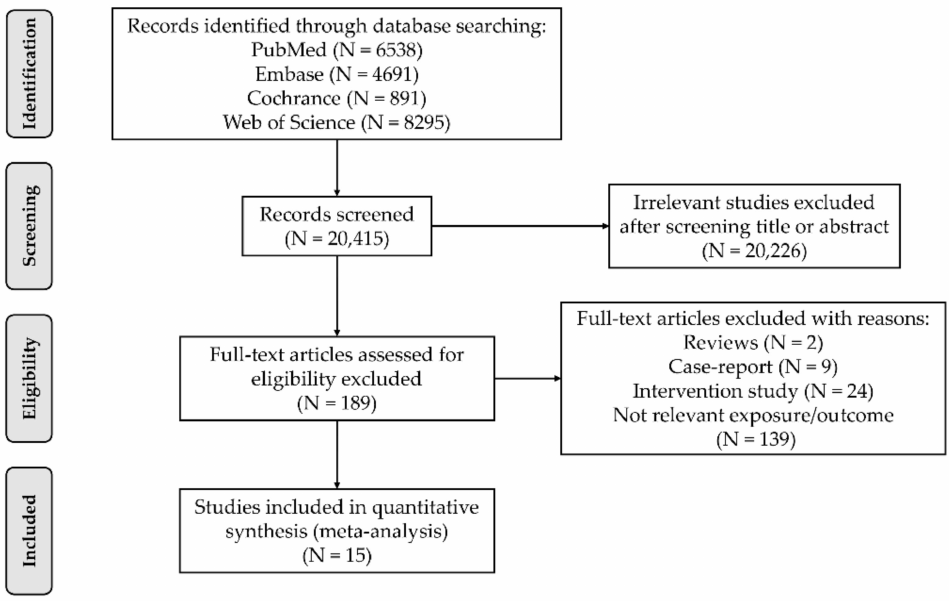
Figure 1. Flow chart of the study selection progress. Table 1. The association between PRM intake and risk of